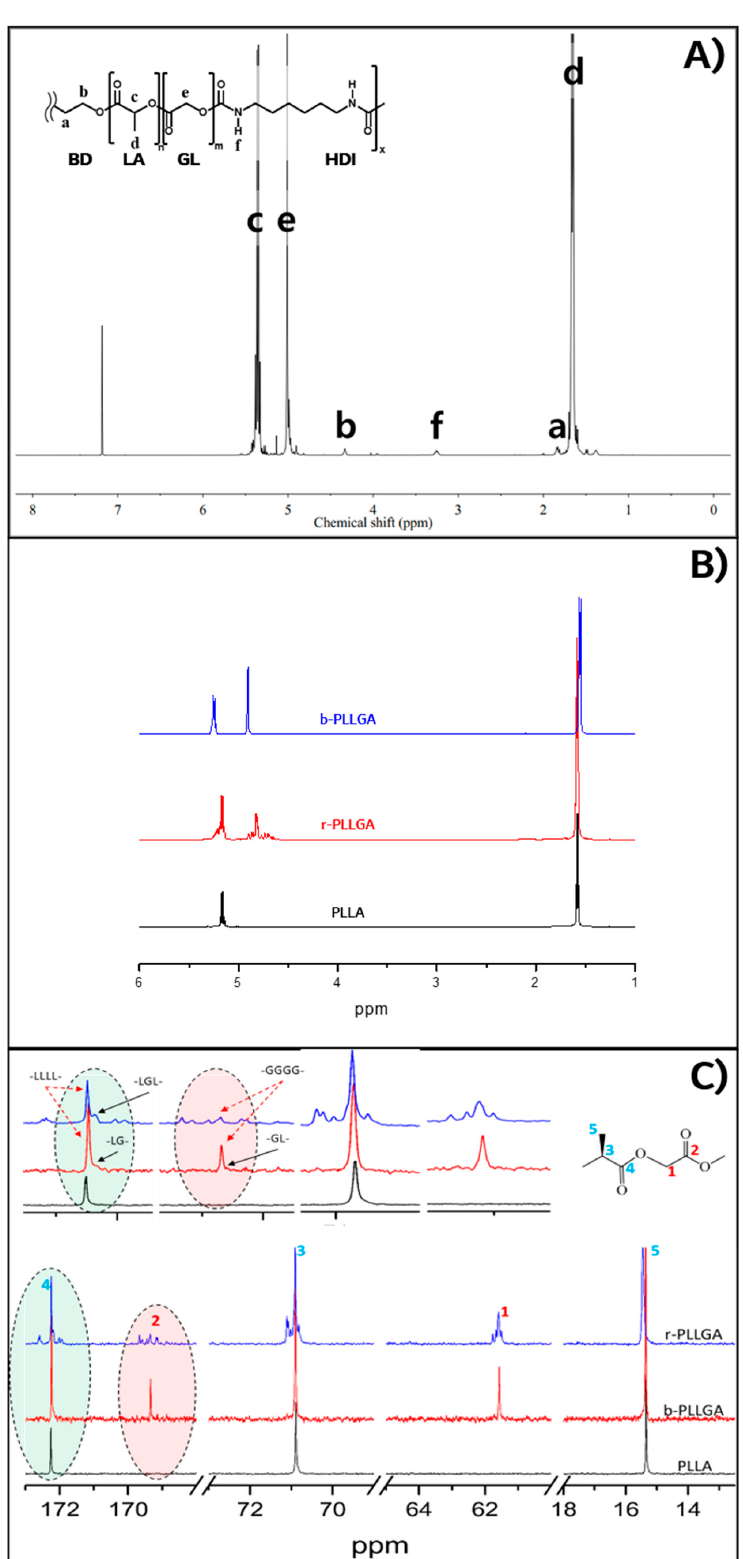
Figure 2. 1 H NMR spectrum of PGA–b-PLA ( A ), 1 H NMR spectrum of b-PLLGA compared with the spectrum obtained from r-PLLGA and PLLA ( B ), 13 C-NMR spectrum of b-PLLGA compared with r-PLLGA and PLLA ( C ).